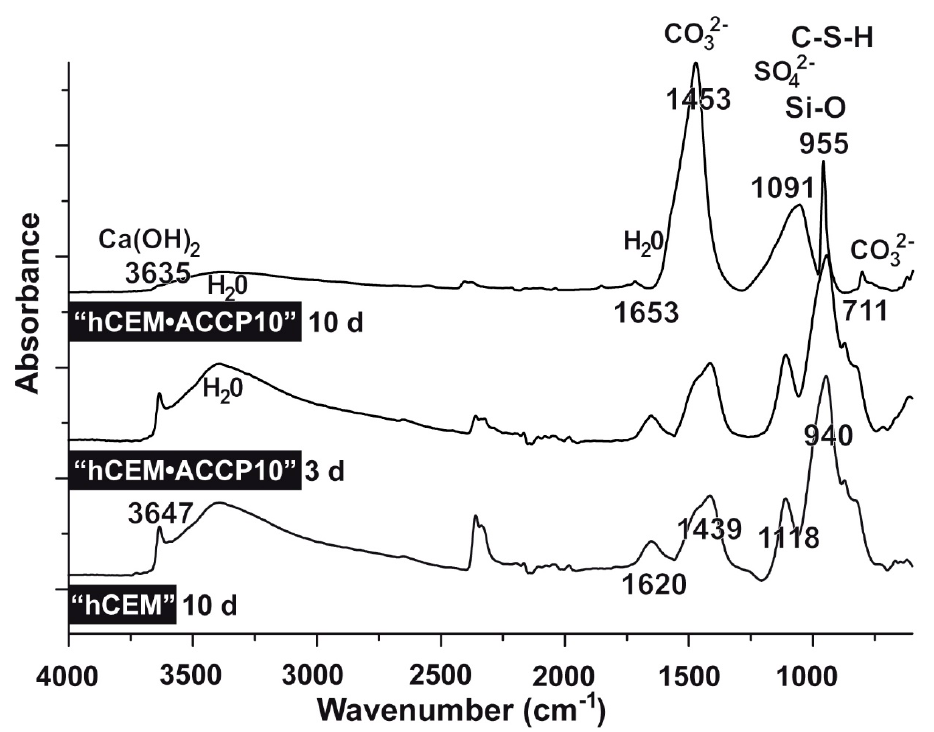
Figure 4. FTIR spectra of hydrated cement, “hCEM”, as well as of the hydrated cement supplemented as indicated. The assignments and the characterization of the peaks of cement, also after processing